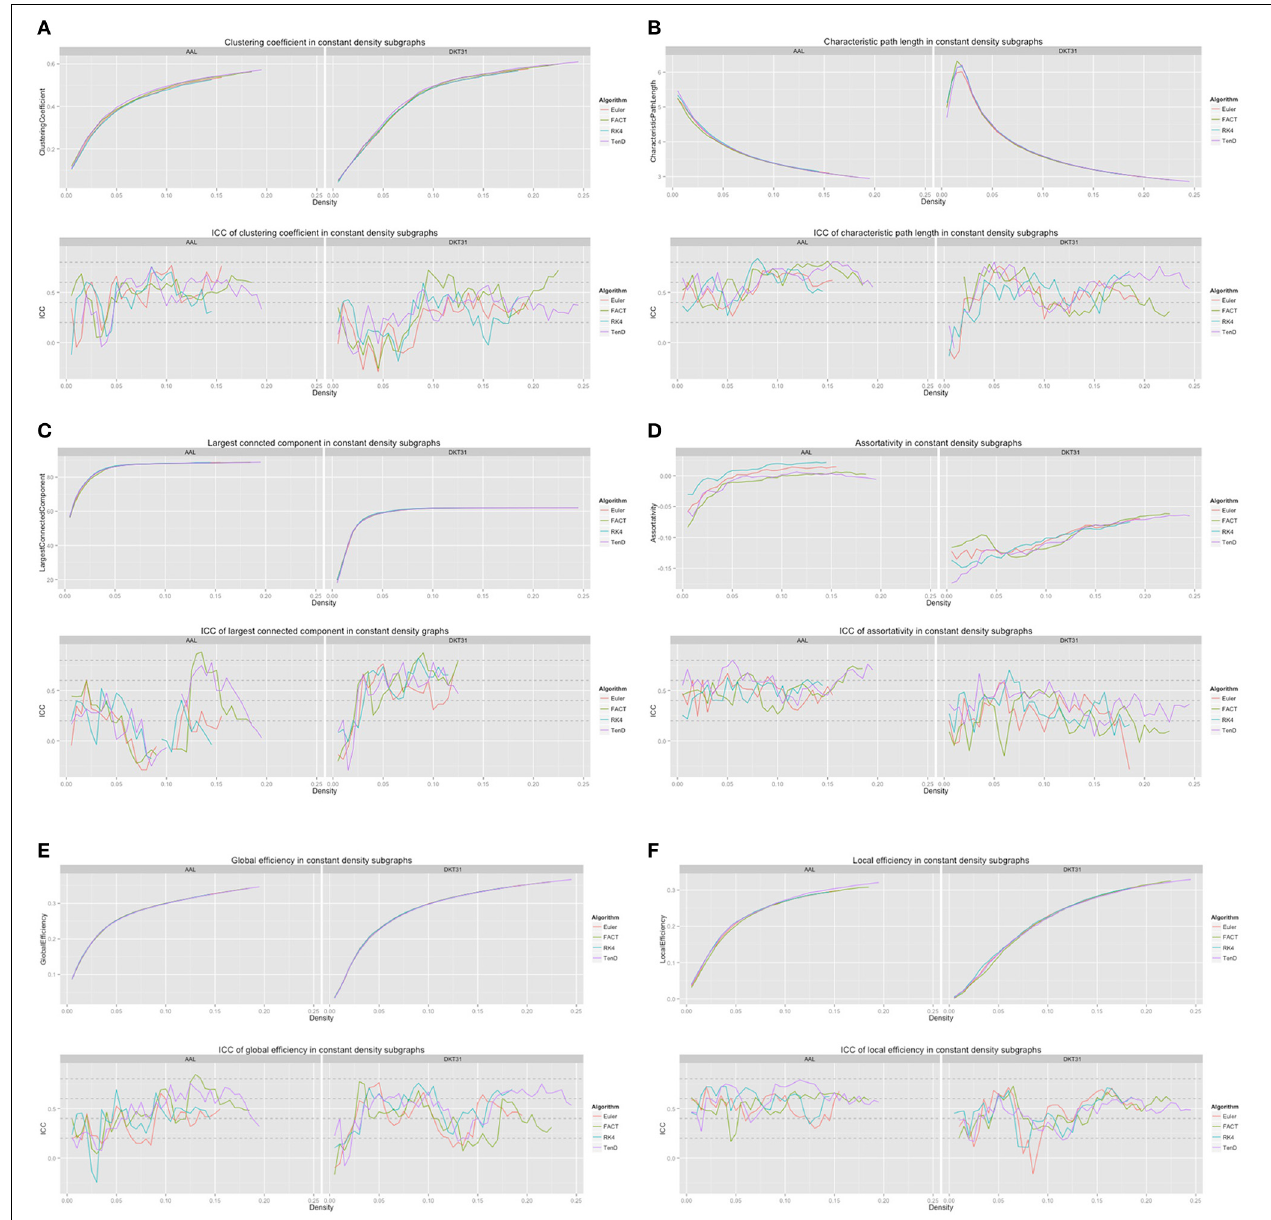
FIGURE 6 | Graph metric vs. graph density plots along with corresponding ICC plots for (A) mean clustering coefficient (B) characteristic path length (C) largest connected component size (D) assortativity (E) global efficiency, and (F) local efficiency.